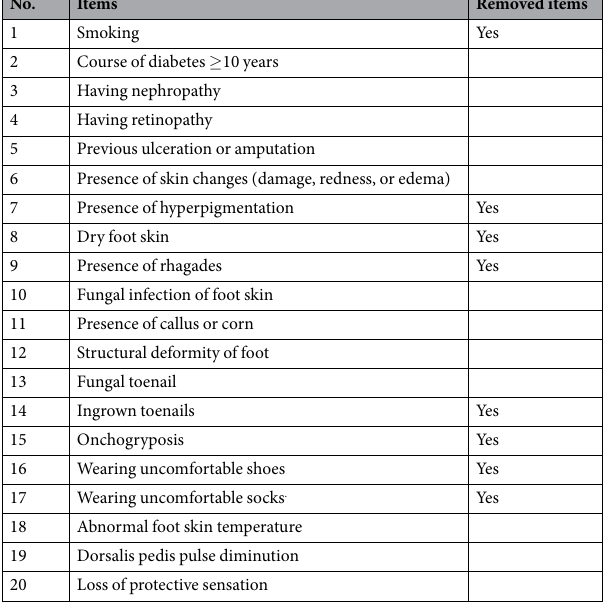
Table 1. Brief diabetic foot risk checklist. * All items were answered in yes-or-no